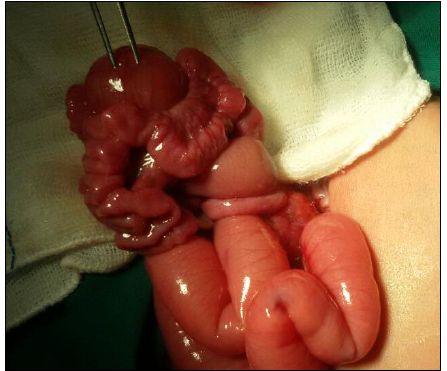
Figure 1: Cystic ileal duplication